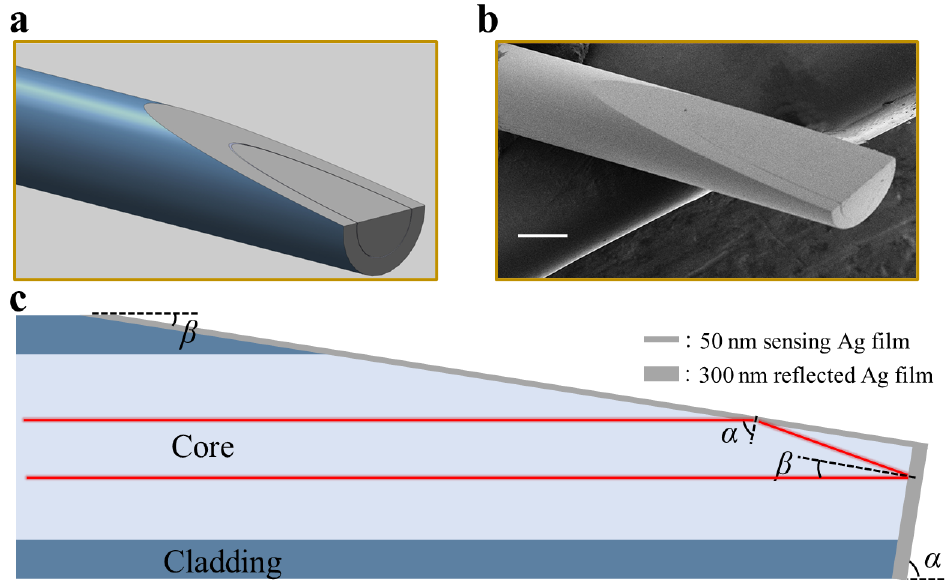
Figure 1. ( a ) Schematic view of the wedged fiber optic SPR probe. ( b ) Scanning electron microscope image of the fabricated probe. Scalebar: 200 μ m.( c ) Definition of involved parameters of the sensing probe.